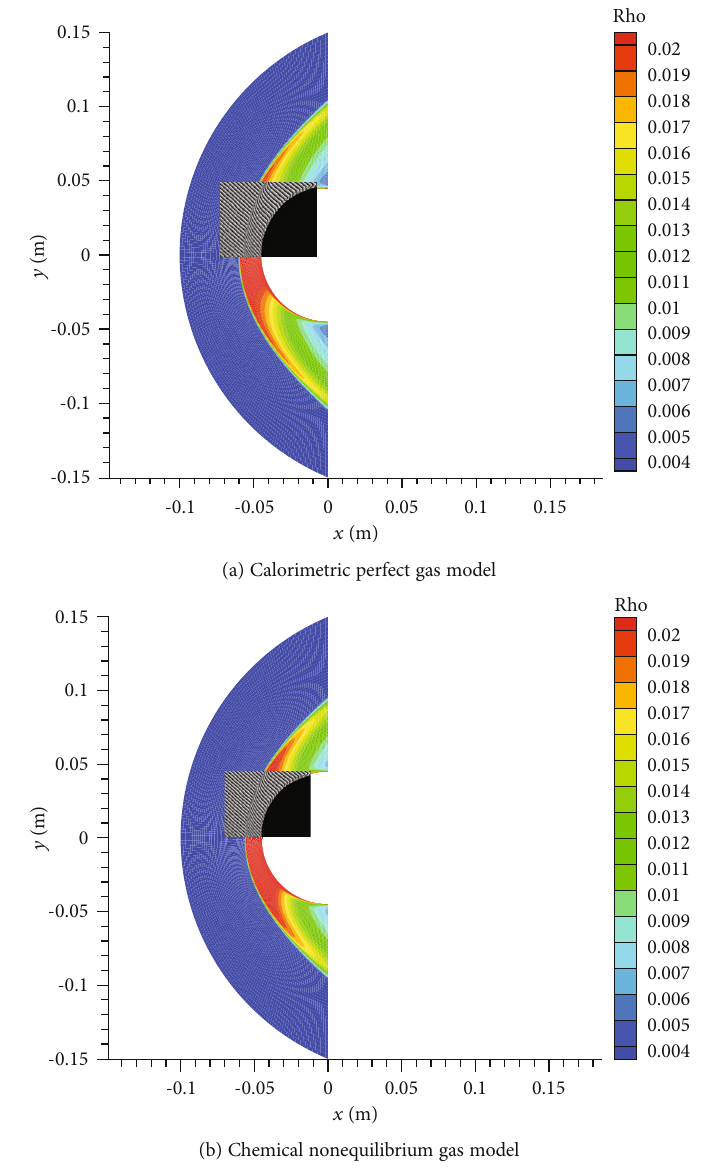
Figure 8: Comparison between the numerical and experimental results.